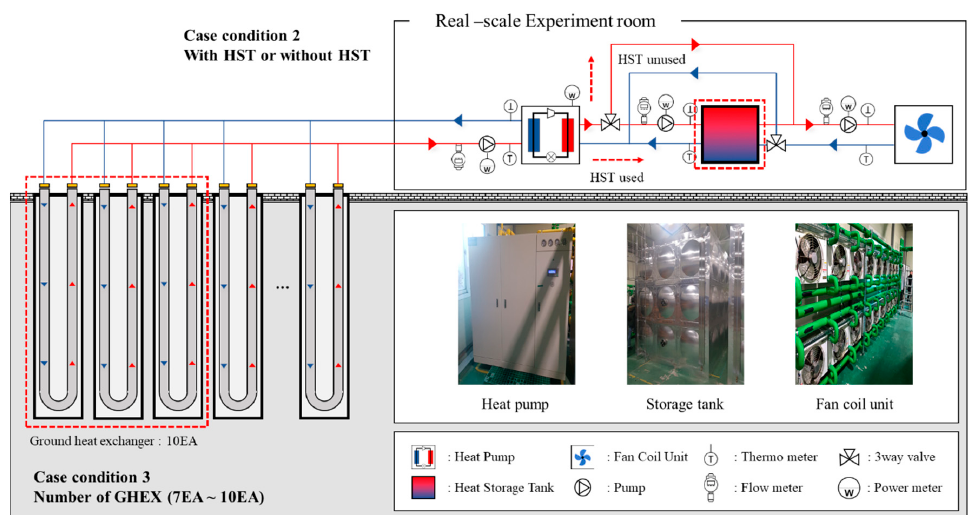
Figure 2. Small-scale experimental setup (Site A).